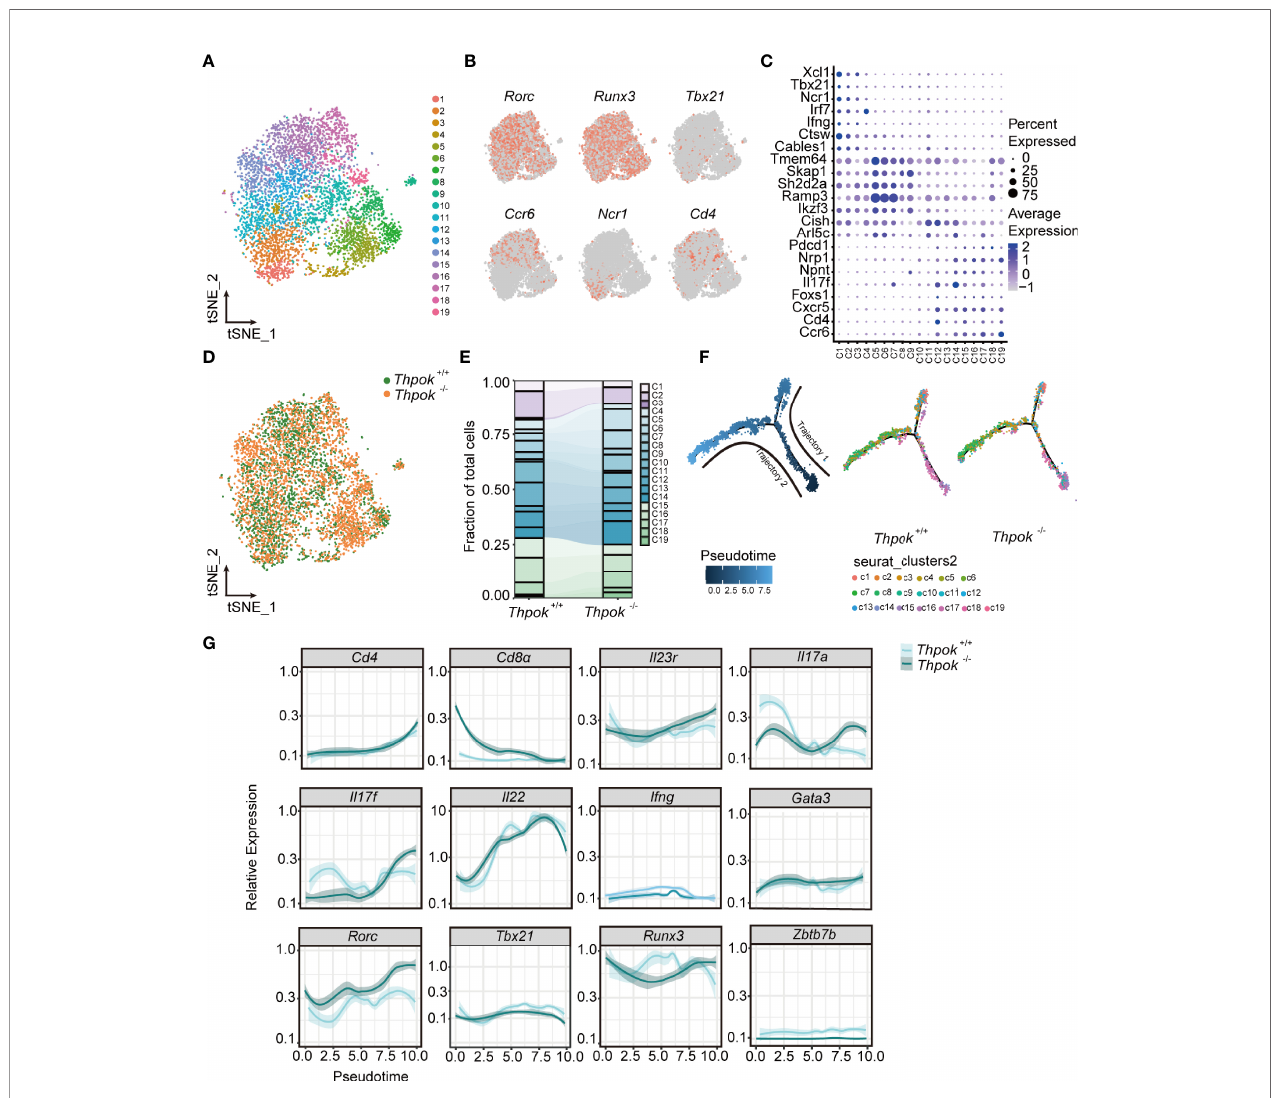
FIGURE 5 | The transcriptomes pro fi le of ILC3s from controls and ThPOK-de fi cient mice at a single-cellular level. (A) Biaxial t-SNE clustering plot of 6023 mixed cells from ThPOK-de fi cient and WT mice. Cells were grouped into 19 distinct clusters (C1-C19, colours indicated). (B) Distribution of key ILC regulators and cell markers shown by two-dimensional tSNE visualization. (C) Dot plot displaying expression of selected and previously described mice ILC subset-speci fi c Transcription factors and cell surface markers used to annotate clusters. Average expression indicates normalized and scaled unique molecular identi fi ers (UMI). (D) tSNE plot showing the distribution of ThPOK-de fi cient and WT ILCs across all clusters, displayed as concatenated samples. (E) Quantitative analysis of WT and ThPOK-de fi cient cells across all clusters. Percentages of WT and ThPOK-de fi cient cells within each cluster among total ILC3 cells. (F) Calculated pseudotime trajectory based on differentially expressed genes in WT and de fi cient cells. The scale indicates the maturation state, from dark blue (least mature) to light blue (most mature). Cells are colored according to computed pseudotime coordinate, celltypes and clusters respectively, all clusters and individual cluster demonstrated in the trajectory. (G) Expression of involved key genes along the trajectory